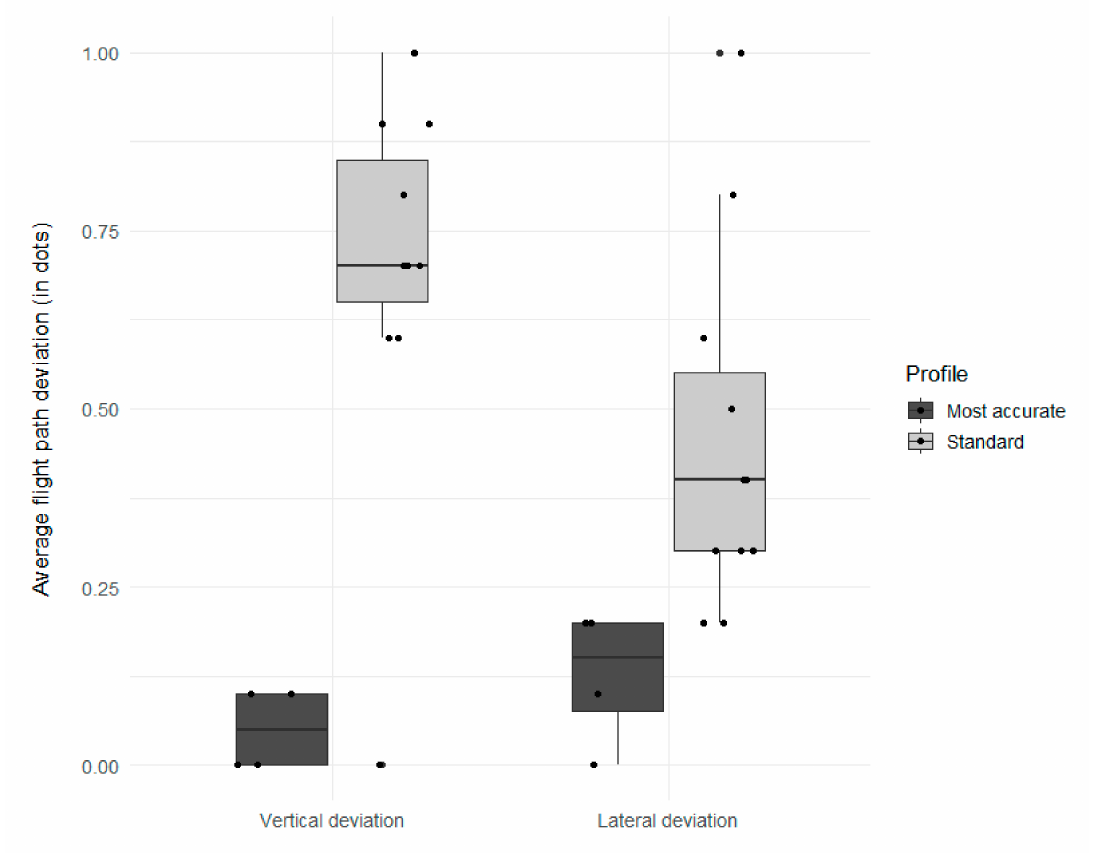
Figure 5. Flight performance during the approach (pre-training session). Absolute lateral and vertical deviations (in dots, the arbitrary unit of the flight simulator; lower is better) for the 15 pilots (most accurate and standard pilots) who successfully performed a stabilized approach (dots represent individual data). The most accurate pilots had particularly low trajectory deviations (average lateral and vertical deviations ≤ to 0.1 dot). Some of them had a vertical of lateral deviation of 0 since they were below the error detection threshold of the flight simulator. The 5 unstabilized pilots are not represented since they aborted the landing. Each average flight path deviation displayed is in the range of accepted limitations, as it was equal or less than 1